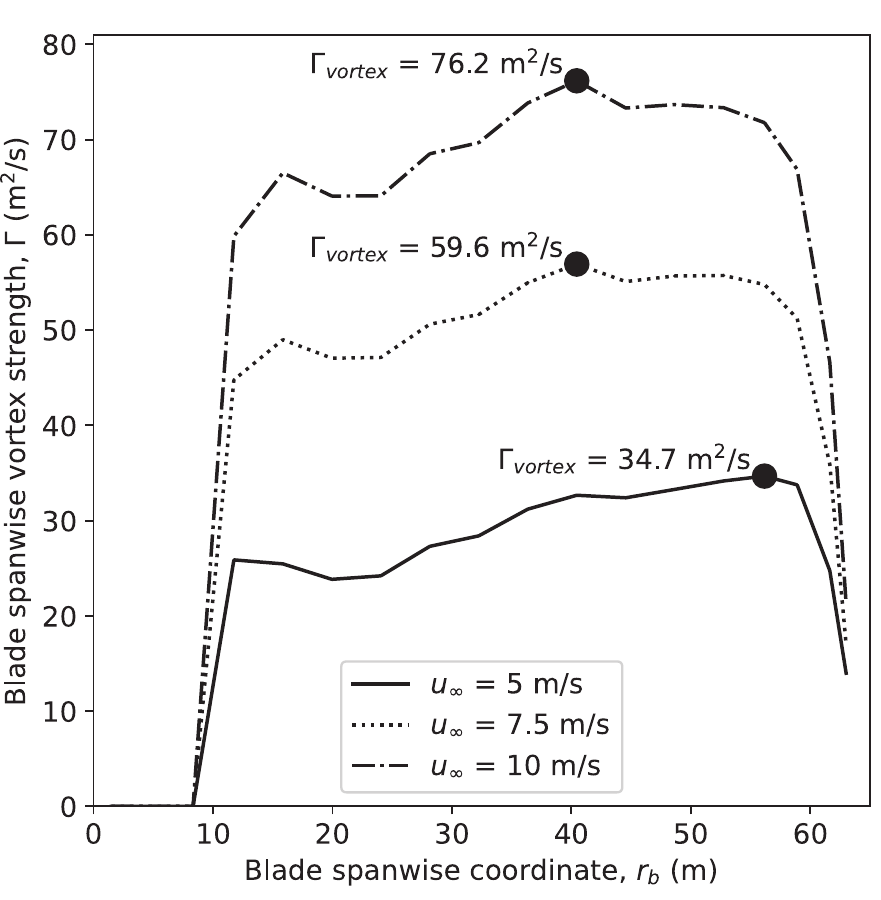
Fig 5. Blade vorticity distribution along the blade of the NREL 5-MW reference turbine calculated using OpenFAST. Note that solid circles identify the maximum spanwise vorticity, which corresponds to the strength of the corresponding blade-tip